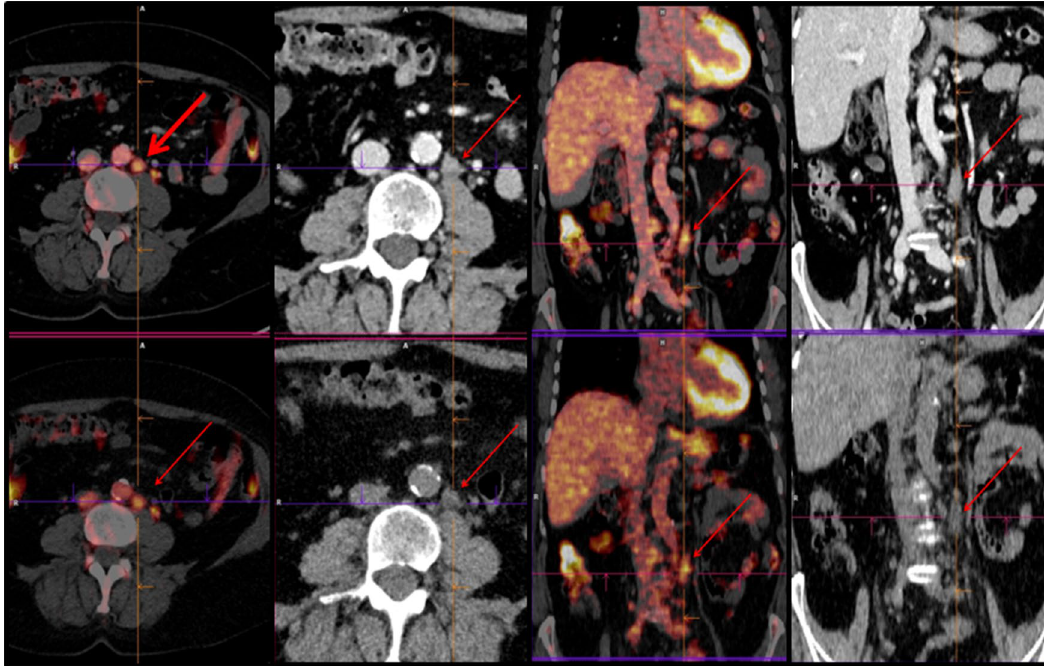
Figure 1. PET/ldCT showed the same number and sites of lesions highlighted by PET/ceCT [DS 5; SUVmax 8].